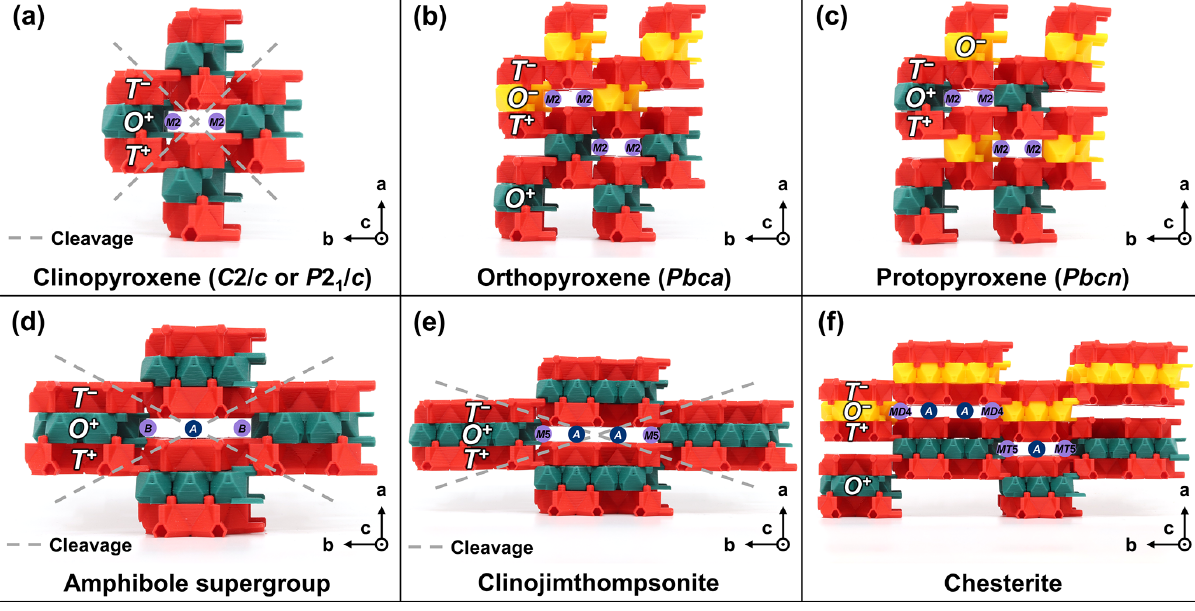
Figure 6. TotBlocks representations of the pyribole series. The T and O modules, as well as circles indicating the locations of additional sites that occupy the spaces between the T - O - T modules, are labelled. (a–c) Polytypes of pyroxenes ( w = 1): (a) clinopyroxene (e.g., Cameron et al., 1973), (b) orthopyroxene (e.g., Carlson et al., 1988), (c) protopyroxene (e.g., Jahn and Martonak, 2009), (d) amphibole supergroup (e.g., Fischer, 1966), (e) clinojimthompsonite, and (f) chesterite (Veblen and Burnham, 1978a,